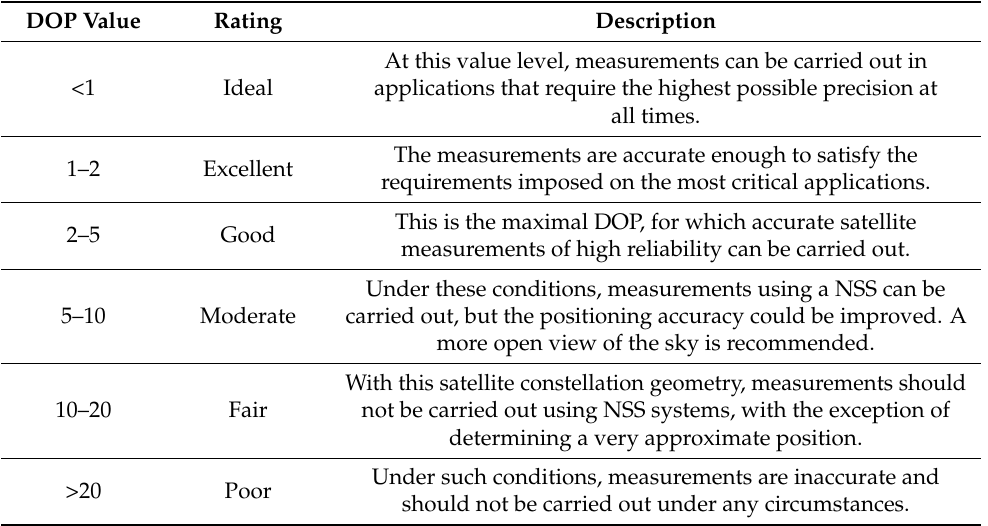
Table 2. Qualitative assessment of the satellite signal depending on the DOP value